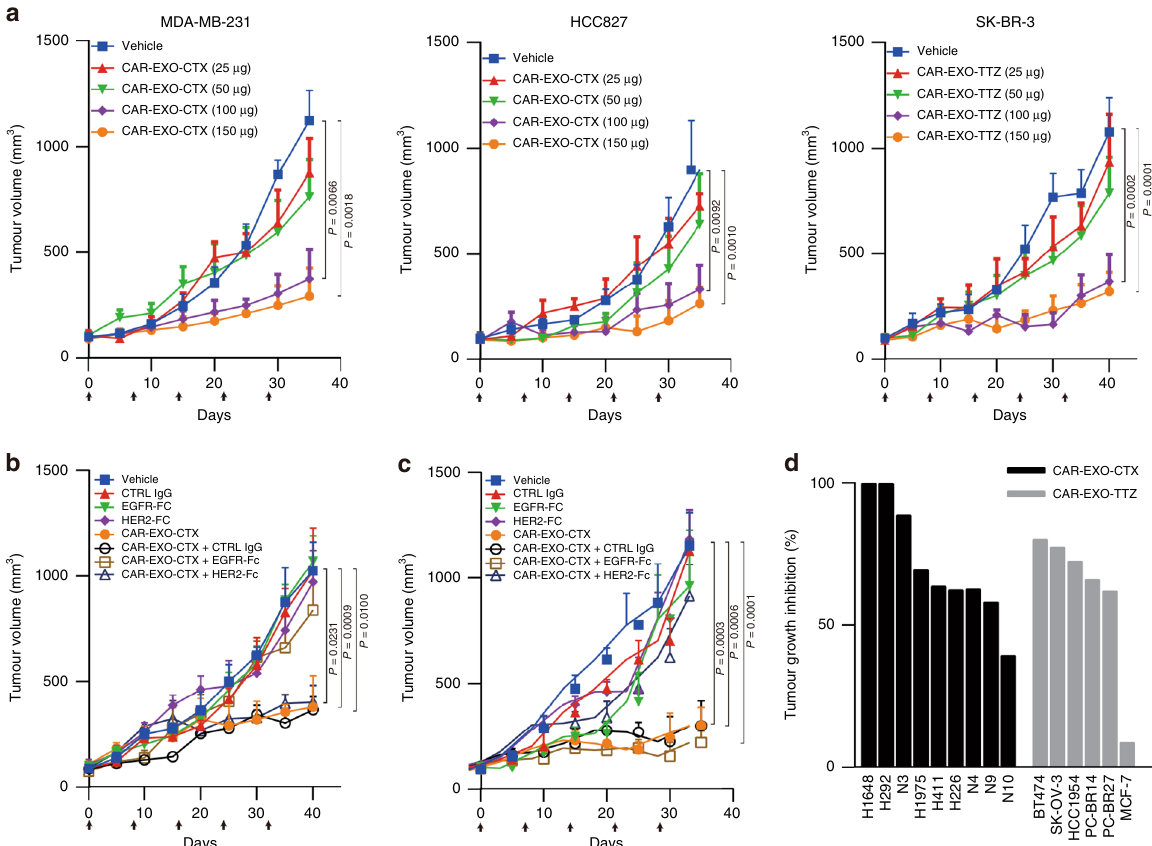
Fig. 5 CAR exosomes have notable antitumour activity in vivo. a Tumour volumes of MDA-MB-231 (left), HCC827 (middle) and SK-BR-3 (right) tumour xenografts after treatment with the indicated treatment, n = 8. b , c Tumour volumes of MDA-MB-231 ( b ) and SK-BR-3 ( c ) tumour xenografts after treatment with the indicated CAR exosome treatment with or without blocking recombinant antigen, n = 8. d Cancer cell lines or patient-derived tumour tissue fragments established as subcutaneous xenografts ( n = 8) and treated with weekly doses of CAR exosomes (100 μ g). Substantial TGI was observed in lung cancer models treated with CAR-EXO-CTX (black bars) and in HER2-positive breast and ovary cancer models treated with CAR-EXO-TTZ (grey bars). Arrows indicate the treatment point ( a – c ). Data are means ± s.e.m. ( a – c ). P values are from a two-way ANOVA followed by Bonferroni post- test ( a – c ). Source data ( a – d ) are provided as a Source Data fi